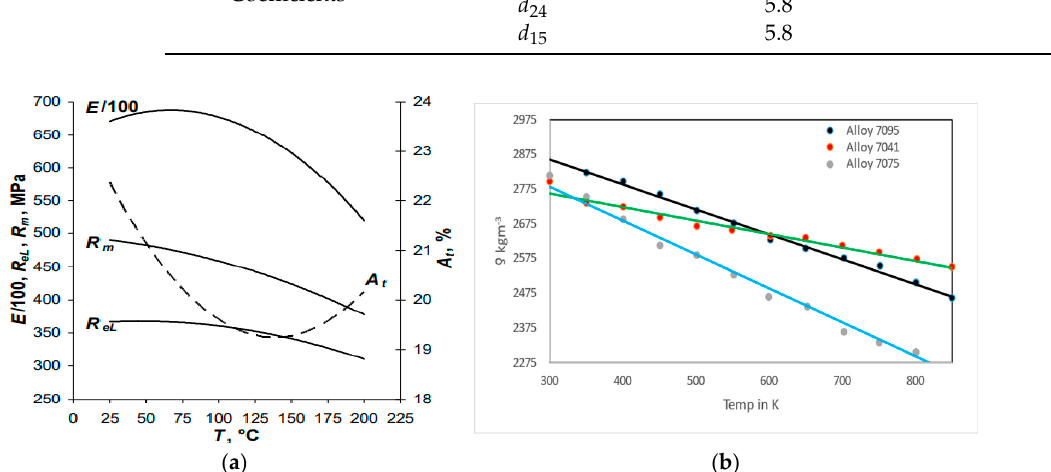
Figure 12. ( a ) Modulus of elasticity [29] and ( b ) density [30] of the aluminum beam at different temperature.